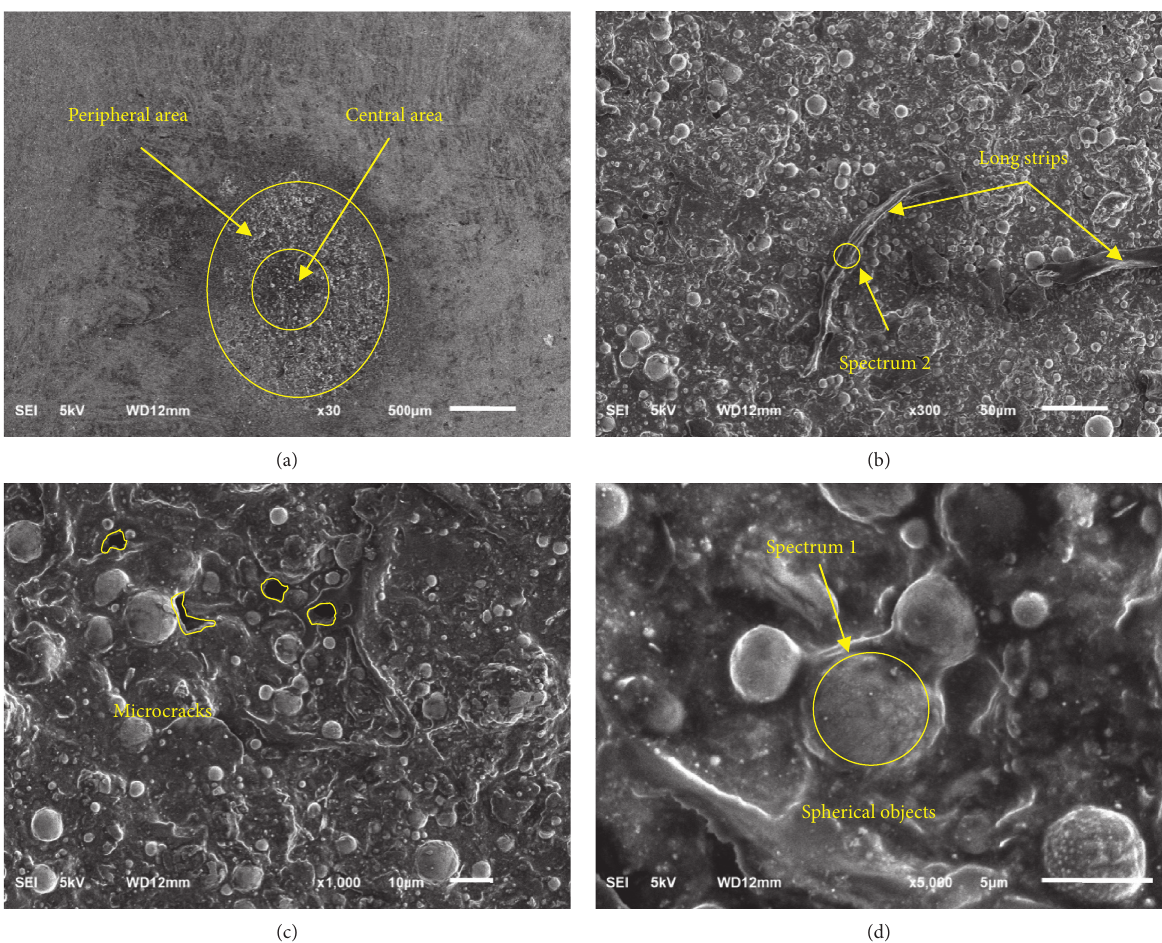
Figure 6: Surface SEM images of different areas of material after erosion. (a) Erosion of the entire area. (b) Long strips in the central area. (c) Erosion of microcracks. (d) Spherical objects in the peripheral